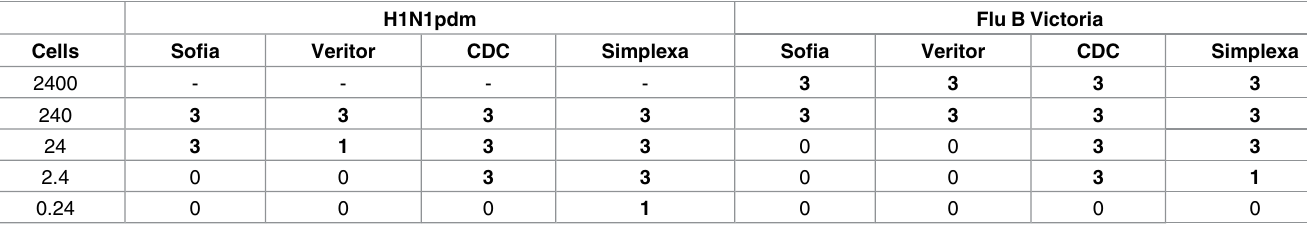
To normalize the differences between virus and infected cells in PBS, the SRS values were con- verted to a percentage of the PBS value (Table 8 and S2 Fig). For the Sofia and Veritor assays, the viruses and infected cells in SRS produced about 26% or lower signal than in PBS. With the Liat assay lower Ct values were found in SRS ( Δ Ct ~ 2 to 4). But, for the Simplexa assay the results were somewhat mixed. In general, these results were consistent with the previous matrix comparison results that were conducted with only virus thereby suggesting that the detection of target molecules in virus and infected cells are affected in the same manner by the SRS matrix.